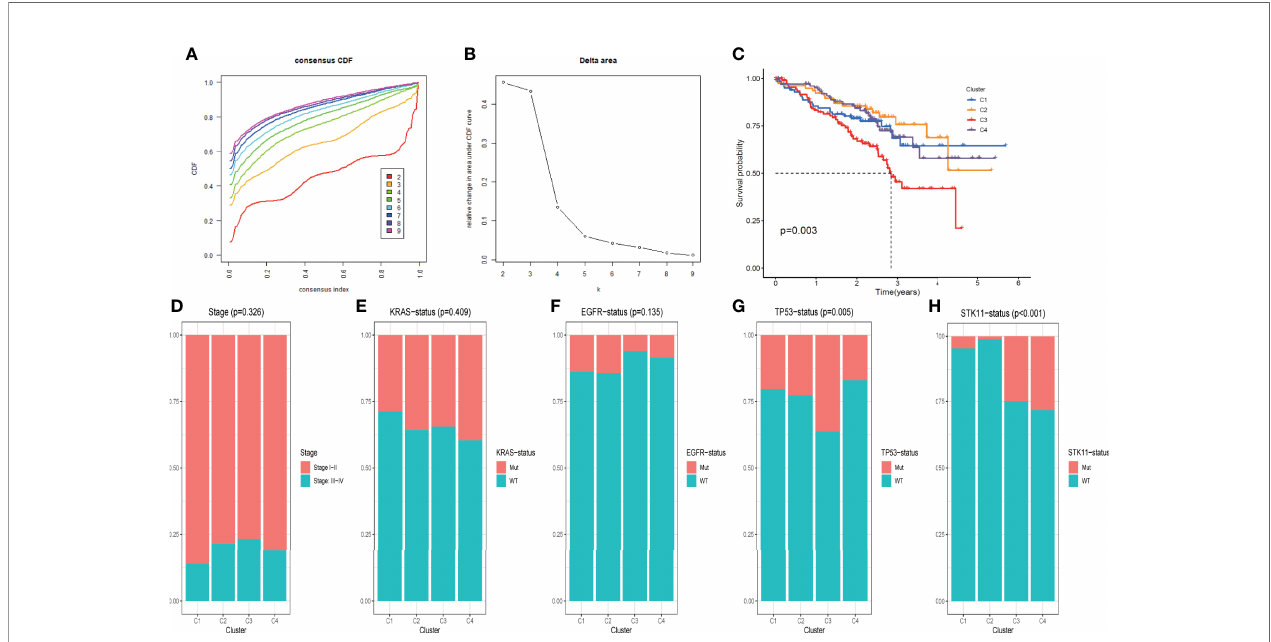
FIGURE 3 | DRG-based classi fi cation of LUAD patients and their corresponding clinicopathological features (A) CDF curves of the consensus score (k = 2 – 9) in the GSE72094 cohort. (B) Relative change in the area under the CDF curve (k = 2 – 9) in the GSE72094 cohort. (C) Kaplan – Meier survival analyses of patients in clusters C1, C2, C3, and C4 in the GSE72094 cohort. (D – H) . Comparisons of the clinicopathological variables including stage (D) , KRAS mutation status (E) , EGFR mutation status (F) , TP53 mutation status (G) , and STK11 mutation status (H) among patients with clusters C1, C2, C3, and C4 in the GSE72094